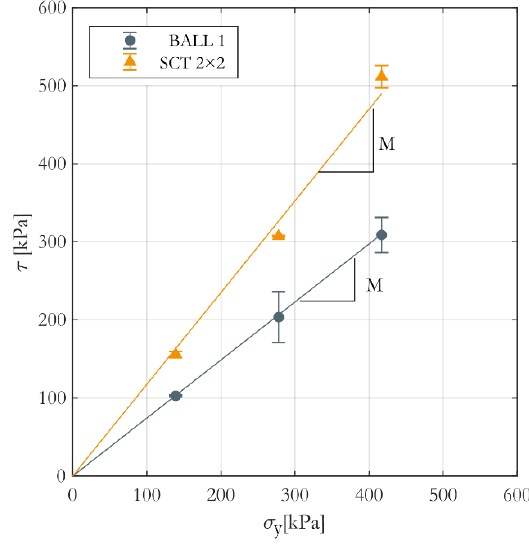
Figure 6. Failure envelopes for both abrasive media.